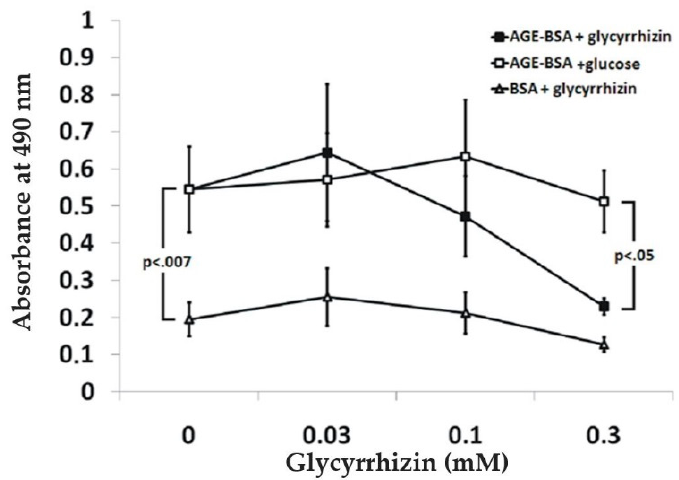
Figure 4. Glycyrrhizin inhibits RAGE binding to advanced glycation end product bovine serum albumin (AGE-BSA). Soluble RAGE binds specifically to AGE-BSA coated plastic wells. The binding was inhibited by glycyrrhizin. N ≥ 3; error bars represent ±SD.